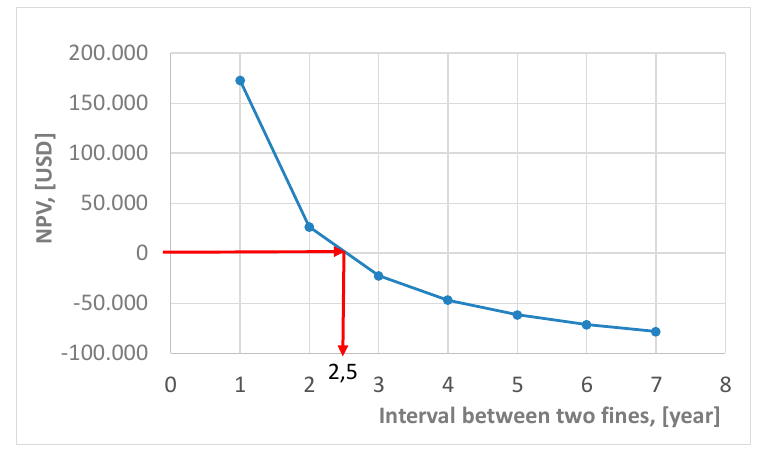
Figure 4. Sensitivity analysis referring to the parameter Interval between two fines.